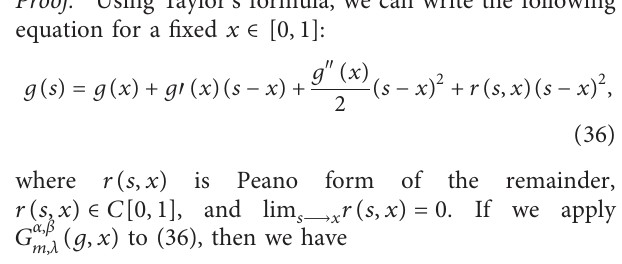
( f, x ) to f ( x ) with respect to m m, 1